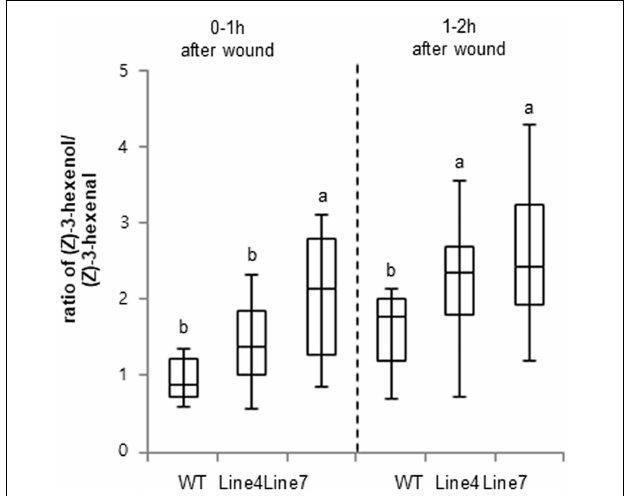
FIGURE 4 | Changes in ADH activity influenced the quality of the emitted wound-induced GLVs. Leaves from WT and sysr1 -transgenic plants were wounded (one leaf per plant), and were immediately placed in a ventilated PET cup containing two PDMS tubes. After 1–2 h, PDMS tubes were collected and analyzed. The peak areas of Z -3-hexenol and Z -3-hexenal (mean + standard deviation; n = 8) were determined as representative values. Different letters represent significant differences at P < 0.05 ( t -test).